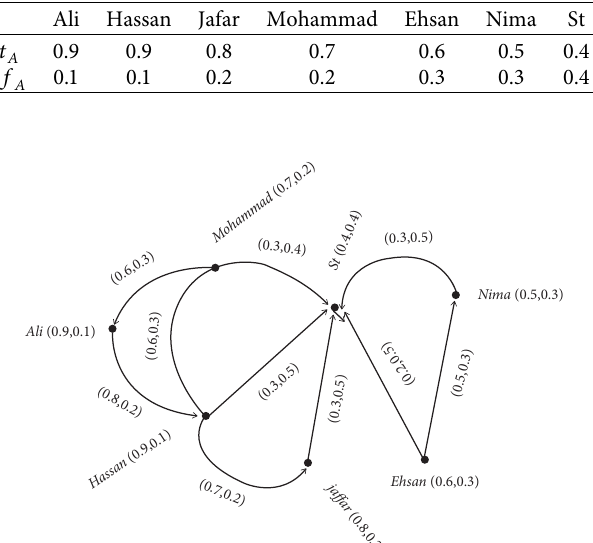
Table 3: The level of staff capability.